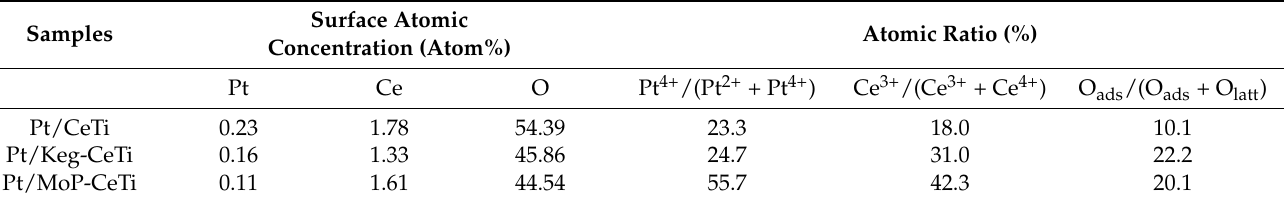
Figure 7. XPS spectra of Pt 4f ( a ) and Ce 3d ( b ) in the Pt/CeTi, Pt/Keg-CeTi, and Pt/MoP-CeTi cata- lysts.